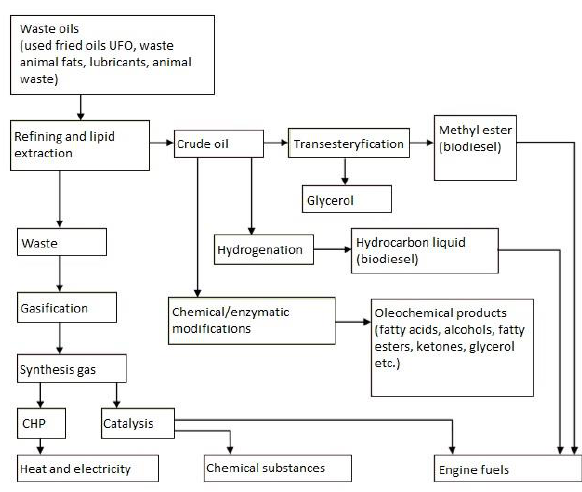
Fig. 4. Concept of biorefinery based on oily waste substances